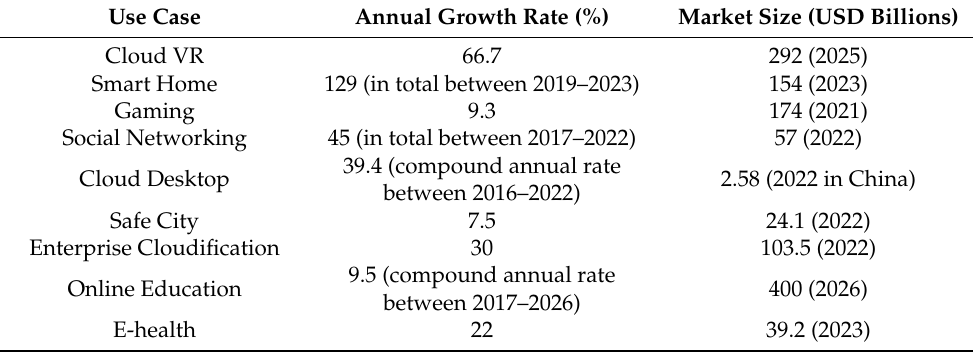
Table 2. Economic predictions for critical F5G services